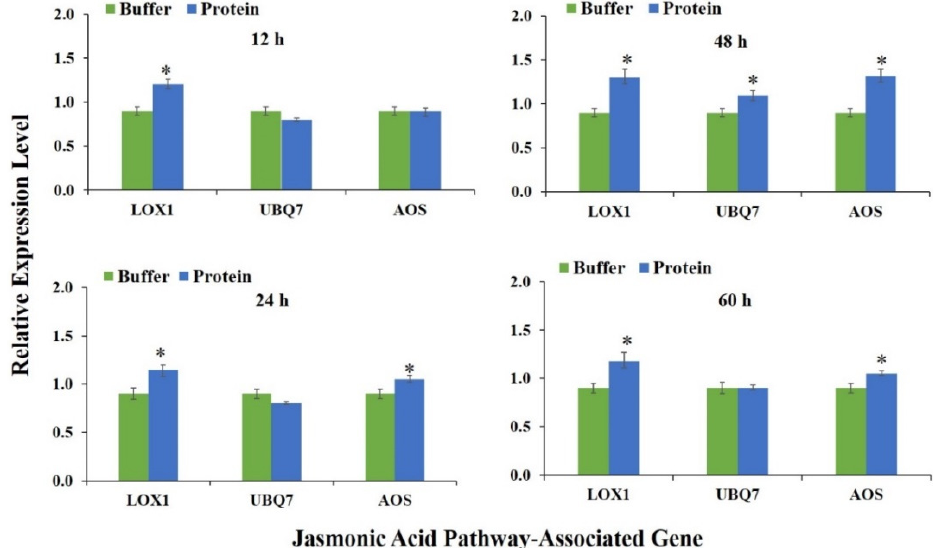
Figure 4. The profiles of relative expression of Jasmonic acid (JA) plant defense pathway related genes assessed in the plant leaves treated with a partially purified protein derived from EPF Lecanicillium lecanii at various post-treatment time intervals. Green and blue colored columns represent respectively the results of buffer-treated (control) and protein-treated plants. For each target gene, asterisk shows statistically significant change in both of the treatments (Student’s paired t -test; p ≤ 0.05).